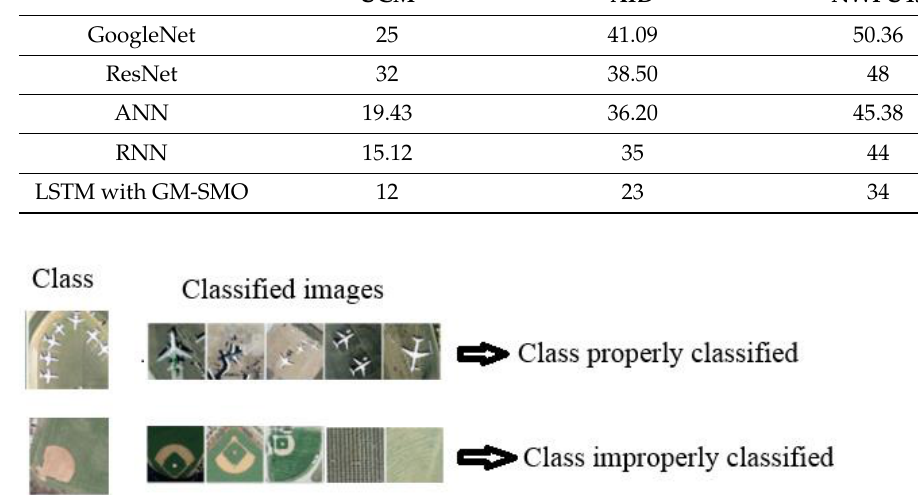
Figure 15. Sample classification output image.